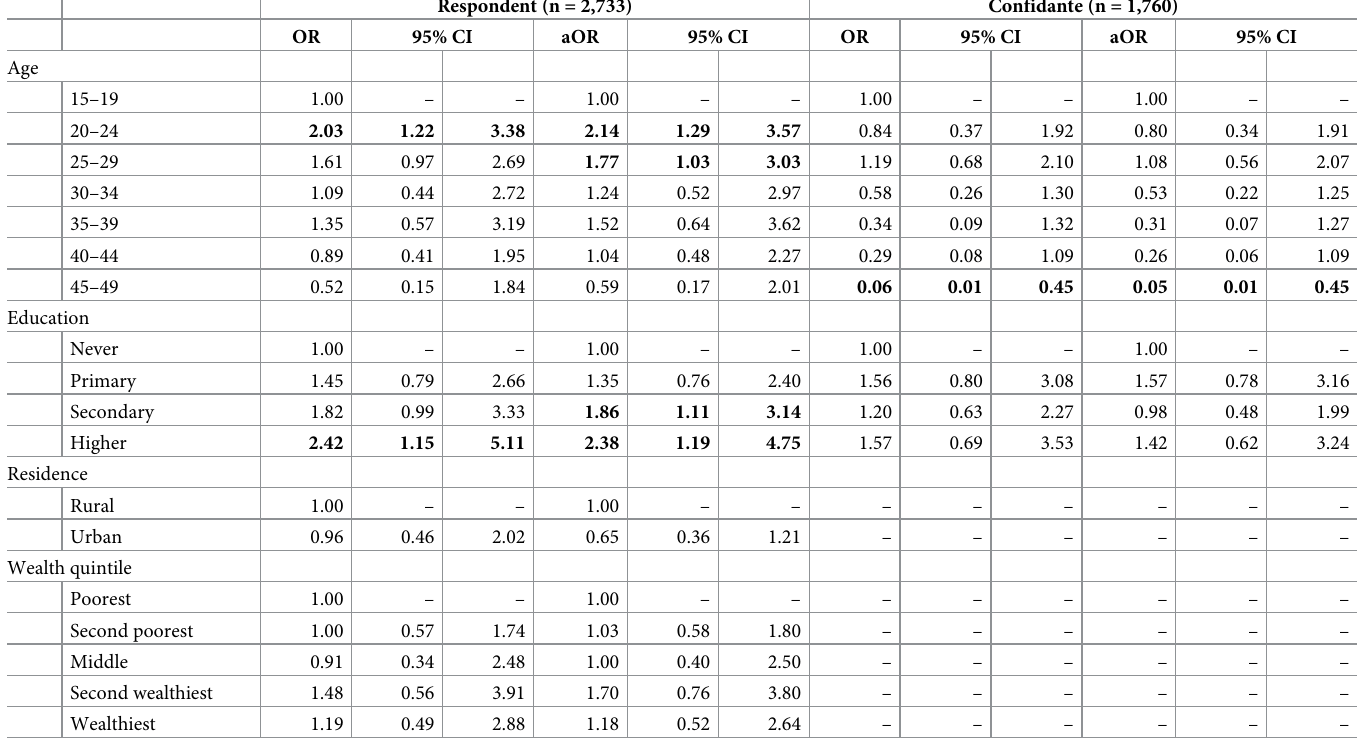
1 Bolding indicates statistical significance at the p < 0.05